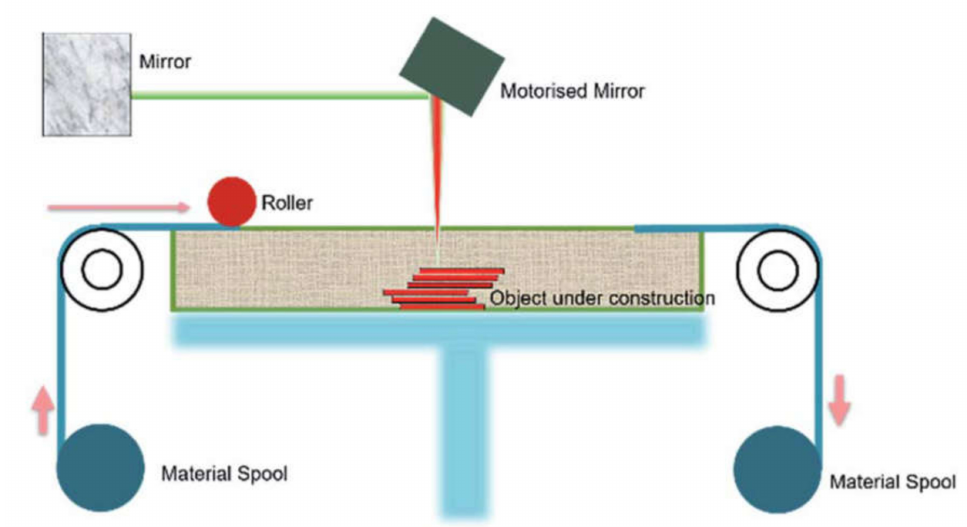
Figure 6. Schematic of the sheet lamination process [33]; published under the open access Creative Commons license with the Royal Society of